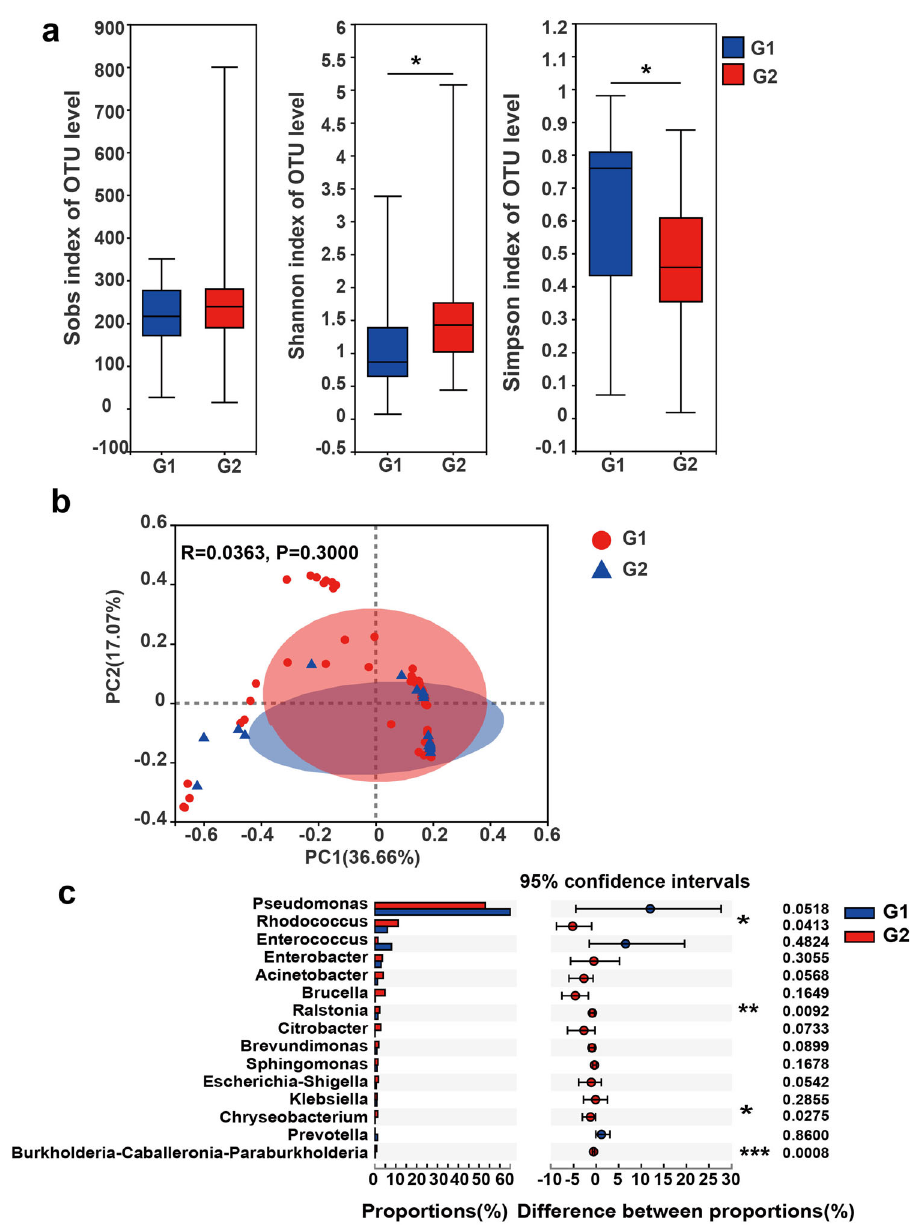
Fig. 4 Changes in the intratumor microbiomes of patients with PTC in different sexes. a α -Diversity at the OTU level (estimated using Sobs, Shannon, and Simpson indices) in patients of different sexes with PTC (* p < 0.05 and ** p < 0.01). Error bars indicate SD. b PCoA score plots based on the Bray – Curtis distance at the OTU level in patients of different sexes with PTC. Wilcoxon rank-sum test and ANOSIM were used for the analysis of intragroup differences in α -diversity, Simpson index, and PCoA analysis, respectively. c Microbiome alterations at the genus level in patients of different sexes with PTC. Differences between groups were analyzed using the Wilcoxon rank-sum test, and the 95% con fi dence interval (CI) was calculated using the bootstrap method. G1: male; G2: